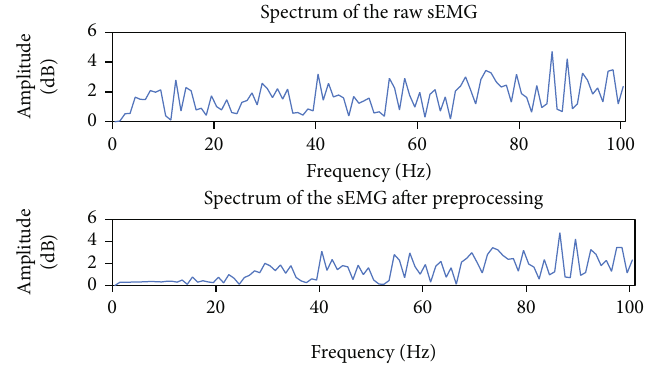
Figure 4: Comparison of sEMG signals before and after denoising.